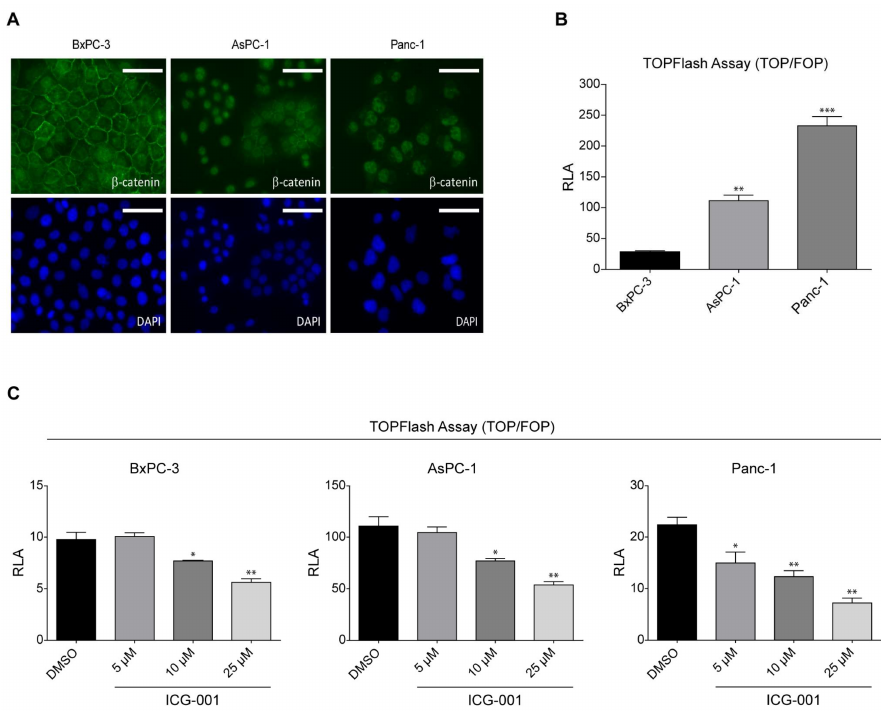
Figure 1. K-Ras activating mutation increases Wnt/ β -catenin signaling in human pancreatic cancer cells. ( A ) BxPC-3, AsPC-1, and PANC-1 pancreatic cancer cells were assayed by immunofluorescence to determine cellular localization of β -catenin. BxPC-3 cells, expressing wild type K-Ras , showed distinct membrane localization of β -catenin and weak, diffuse nuclear and cytoplasmic staining (DAPI, counterstain). However, in K-Ras mutant cells AsPC-1 and PANC-1 there was virtually no membrane-associated β -catenin. AsPC-1 cells showed diffuse cytoplasmic staining and strong nuclear staining for β -catenin, whereas PANC-1 cells demonstrated strong nuclear staining with limited cytoplasmic staining. Scale bar = 100 µ m. ( B ) TOPFlash reporter gene assay was used to evaluate Wnt/ β -catenin transcriptional activation in BxPC-3, AsPC-1, and PANC-1 cells. BxPC-3 cells exhibited weak Wnt/TCF/ β -catenin-driven luciferase expression. However, AsPC-1 and PANC-1 cells demonstrated enhanced TOPFlash activity. n = 3, ** p < 0.01, *** p < 0.001, compared to BxPC-3. RLA, relative luciferase activity. ( C ) Treatment with ICG-001, a specific, small molecule inhibitor of CREB-binding protein (CBP)/ β -catenin interaction, demonstrated dose-dependent decrease